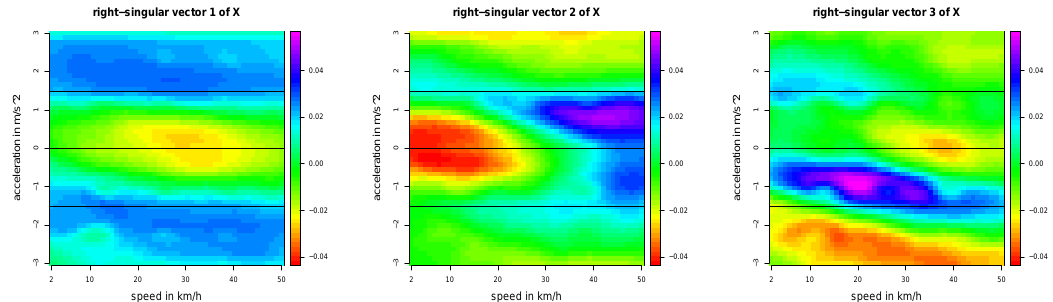
Figure 15. First three right-singular vectors of X given by the first three columns of the orthogonal matrix V